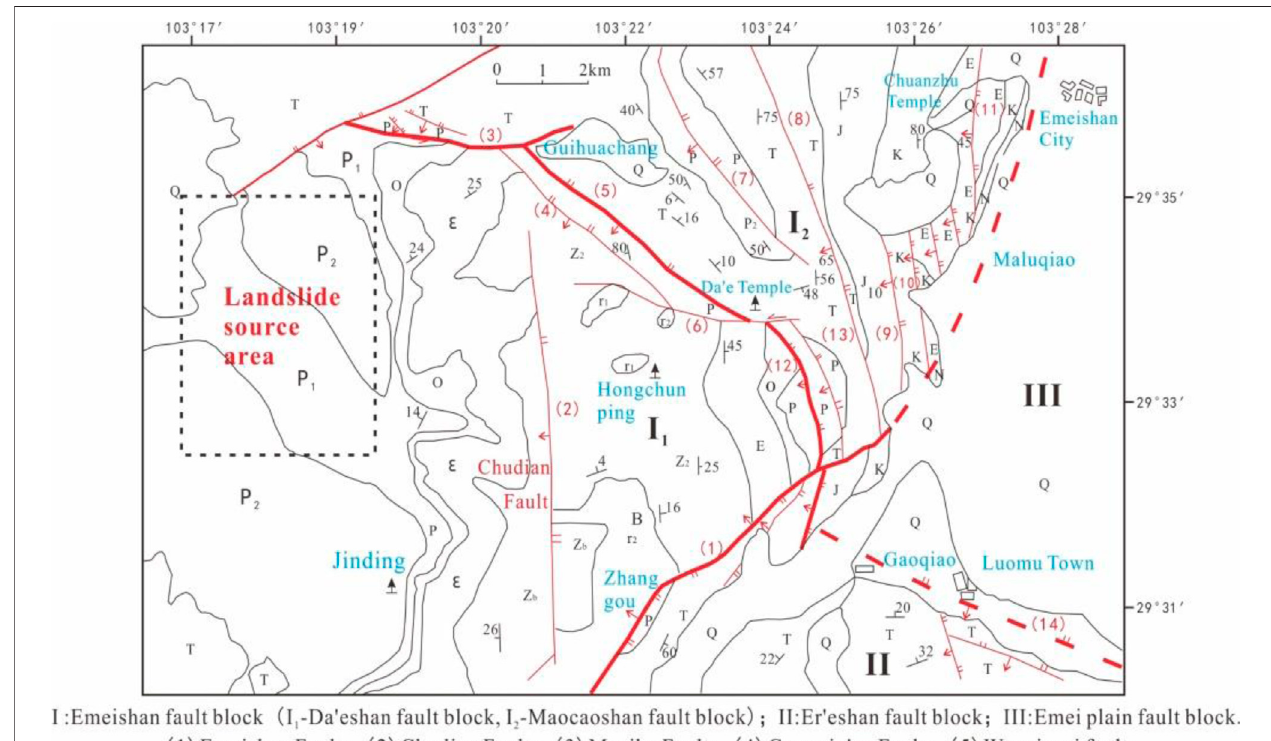
FIGURE 1 | The tectonic setting of the study